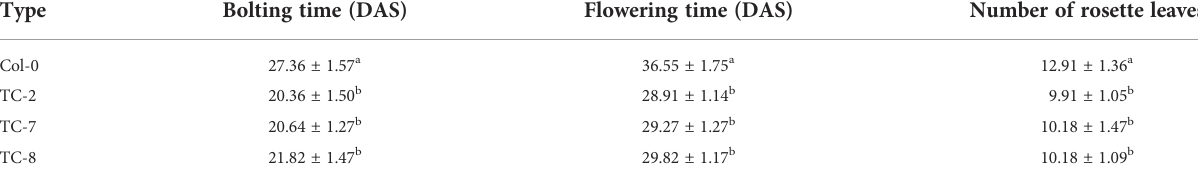
Values represent means ± standard deviation (SD). Different letters in the same column indicate signi fi cant differences